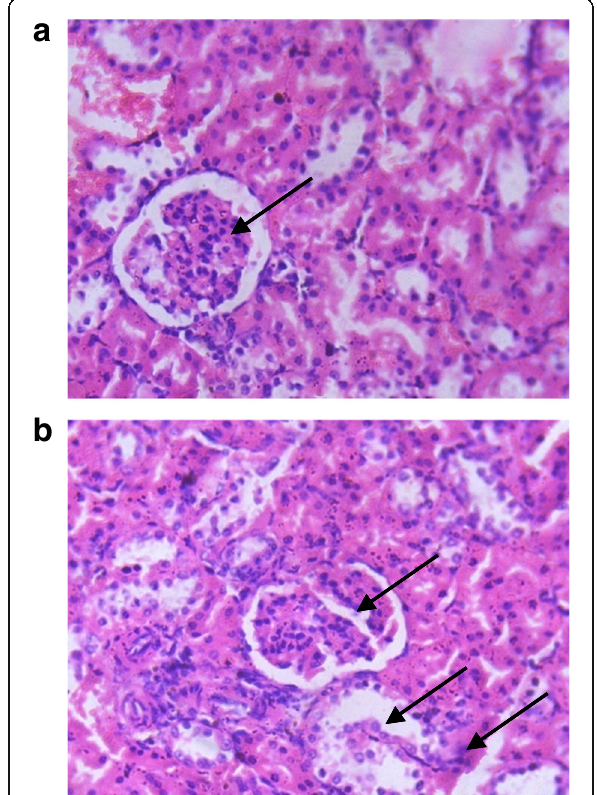
Fig. 2 a Photomicrograph of the liver section of the rats dosed with G. senegalensis showing karyorrhexis and mild congestion (× 40). b Photomicrograph of the liver section of the rats dosed with G. senegalensis showing karyorrhexis, mild congestion, and lymphocytic (×